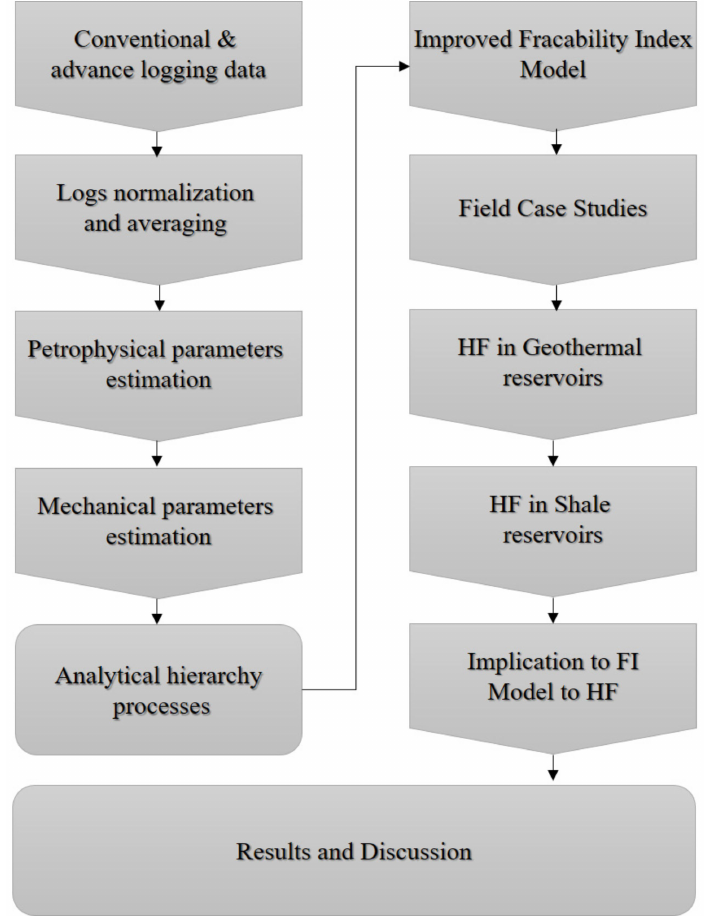
Figure 2. Proposed workflow to develop fracability index